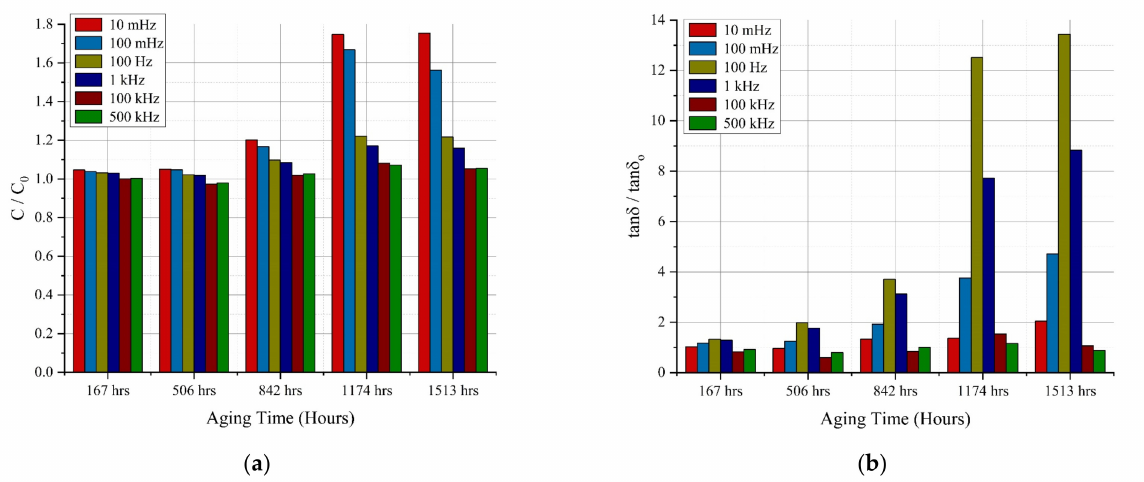
Figure 9. Change in ( a ) capacitance and ( b ) tan δ for different thermal aging periods at 10 mHz, 100 mHz, 100 Hz, 1 kHz, 100 kHz, and 500 kHz for EPR